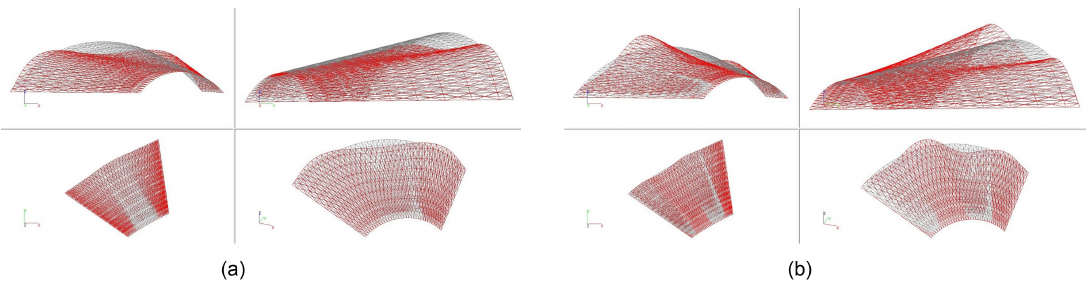
Figure 8: The deformation scheme of truncated cone